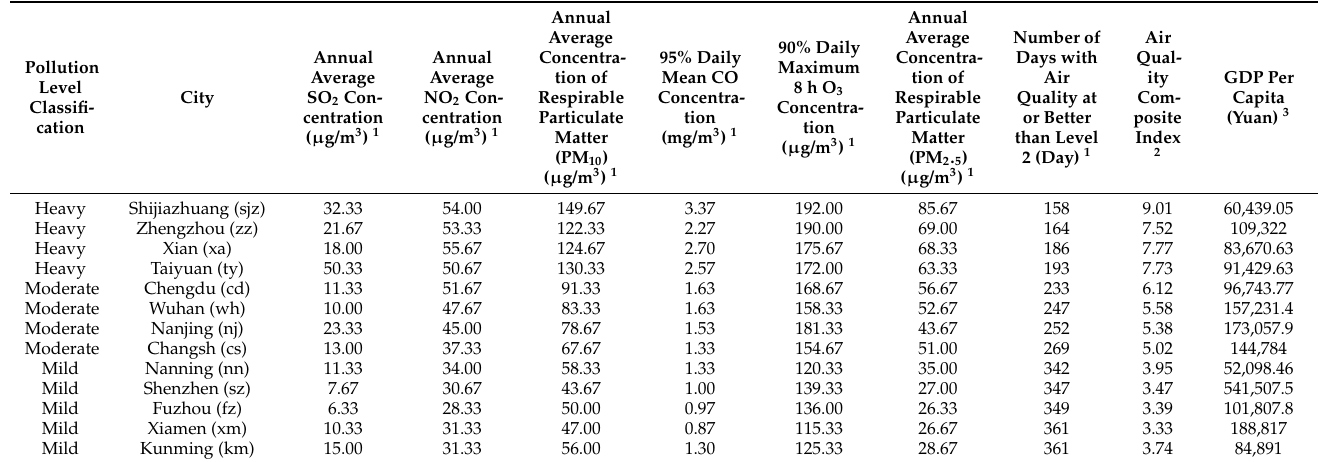
Table A3. Air quality in the experimental cities (2016–2018 three-year average).